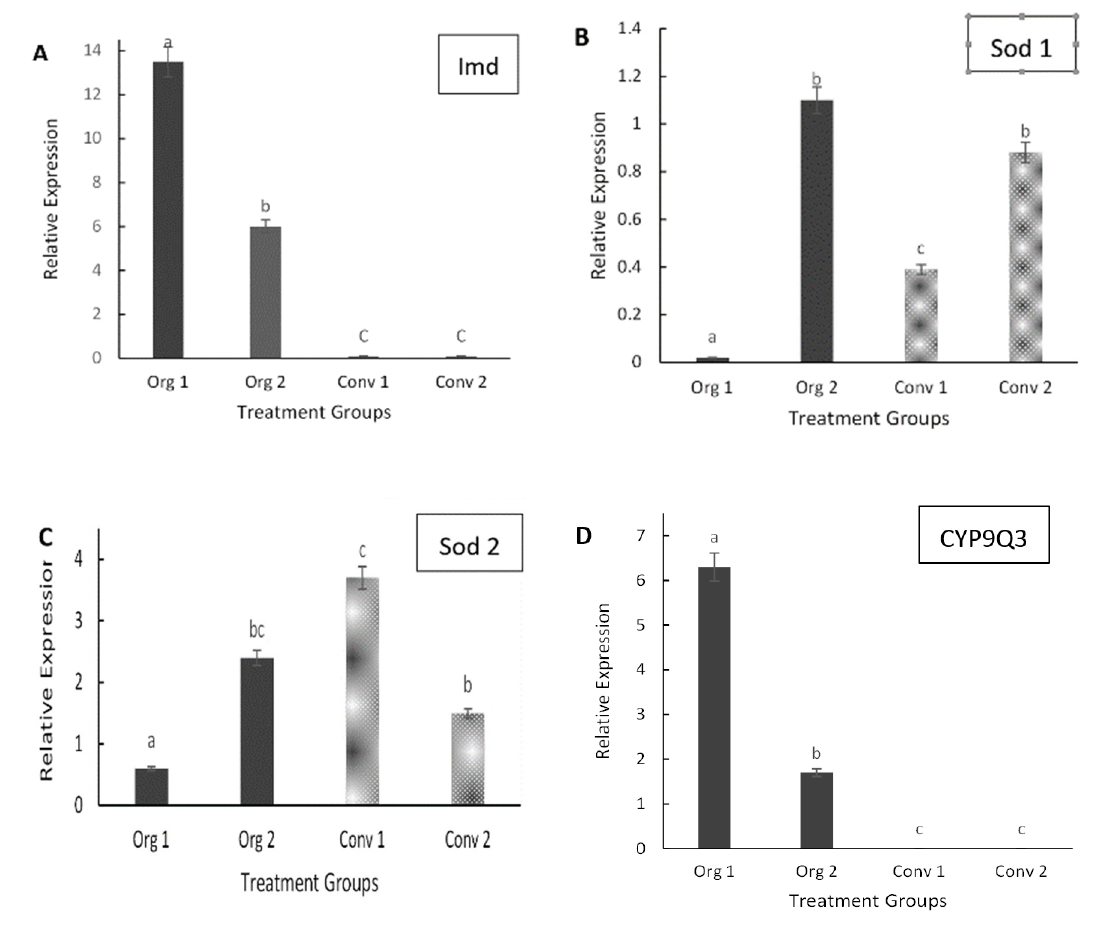
Figure 3. Mean (±SE) relative gene expression in young adult bees collected from: organically managed hives with Varroa mite infestation levels of 0% (Org 1) or 5% (Org 2) and conventionally managed hives with Varroa mite infestation levels of 0% (Conv 1) or 5% (Conv 2). Relative expression data were normalized to β -actin. Different letters above bars indicate treatment differences ( p < 0.05, Tukey’s test). ( A ) Immune deficiency gene. ( B ) Superoxide dismutase 1. ( C ) Superoxide dismutase 2. ( D ) CYP9Q3.